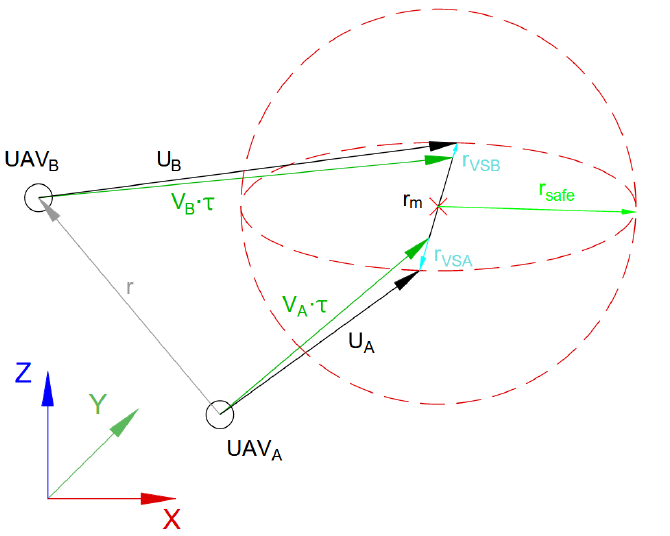
Figure 6. Graphical representation of variables of the algorithm in a 3D cartesian coordinate